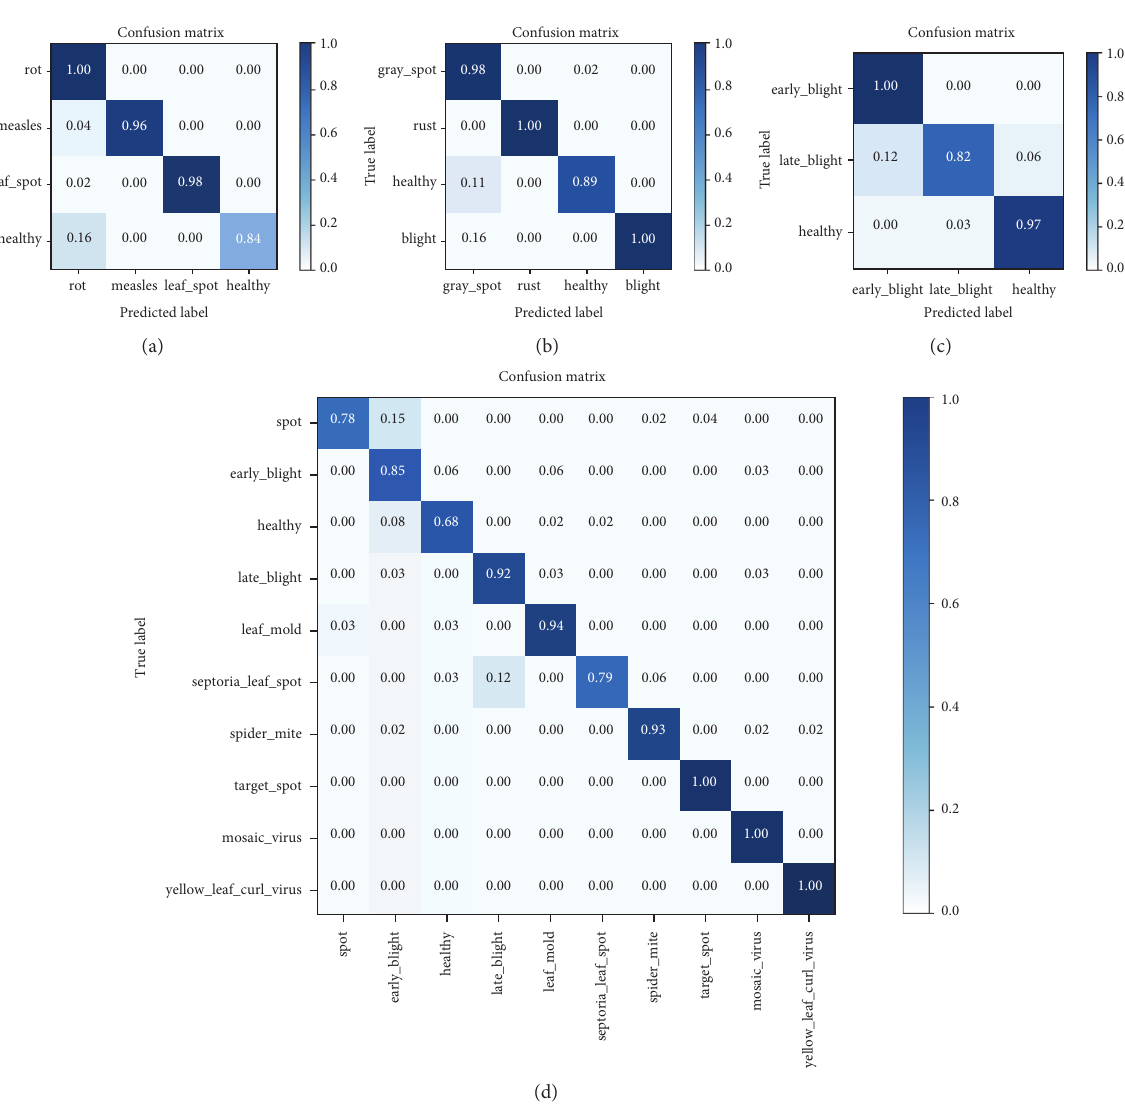
Figure 18: Confusion matrix of different subsets: (a) confusion matrix of grape disease, (b) confusion matrix of corn disease, (c) confusion matrix of potato disease, and (d) confusion matrix of tomato